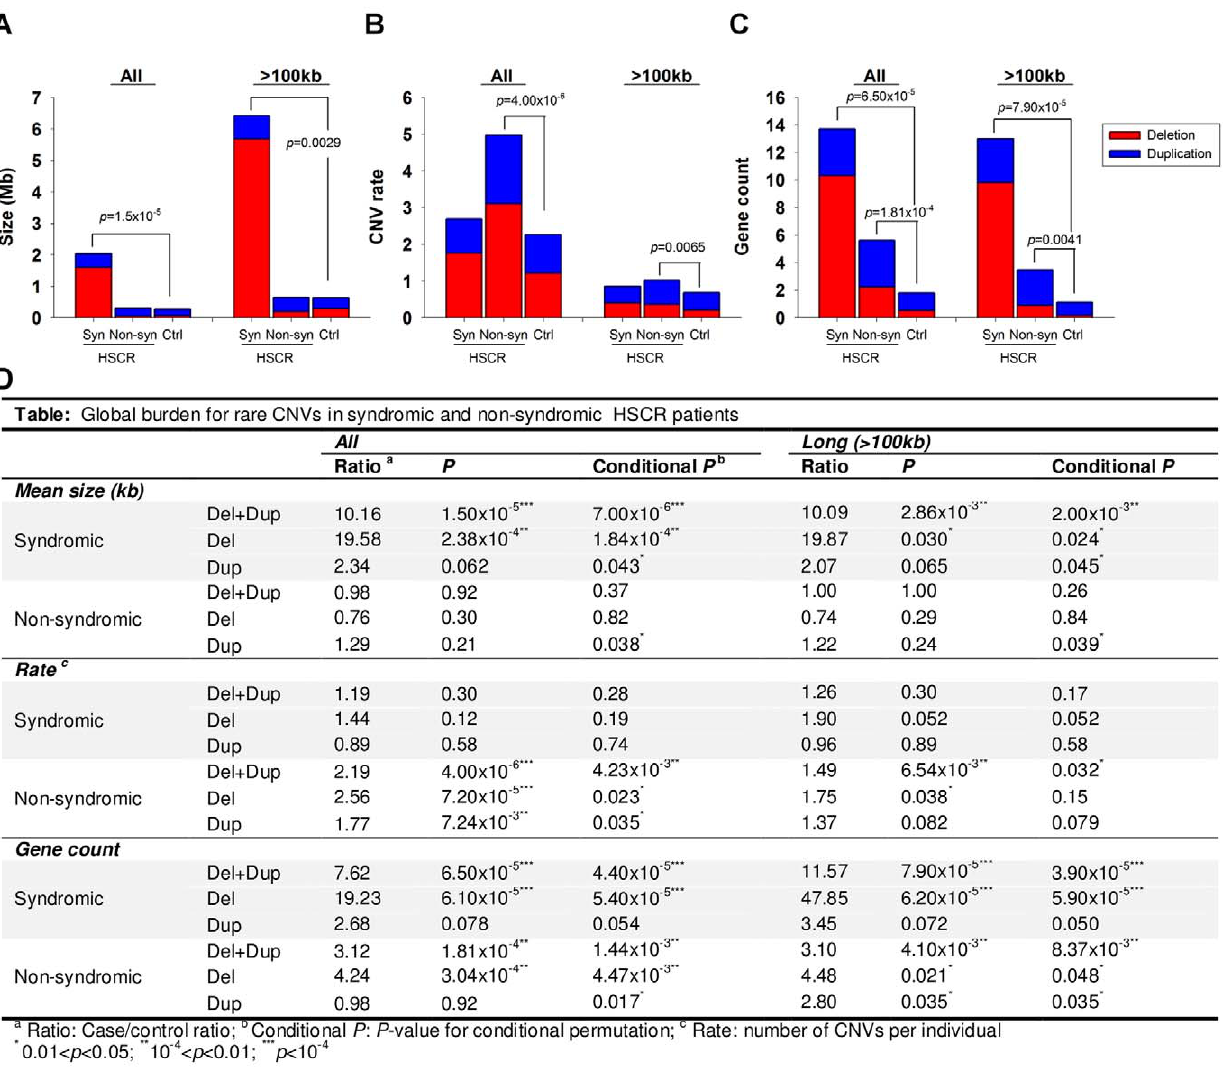
Figure 1. CNV burden for syndromic (Syn) and non-syndromic (Non-syn) HSCR patients relative to controls (Ctrl). The burden was measured with reference to the (A) size, (B) rate and (C) gene count of CNVs. Red and blue bars denote the mean value of the corresponding test for deletion and duplication respectively. Summary statistics as well as conditional permutation p -value was shown in (D).